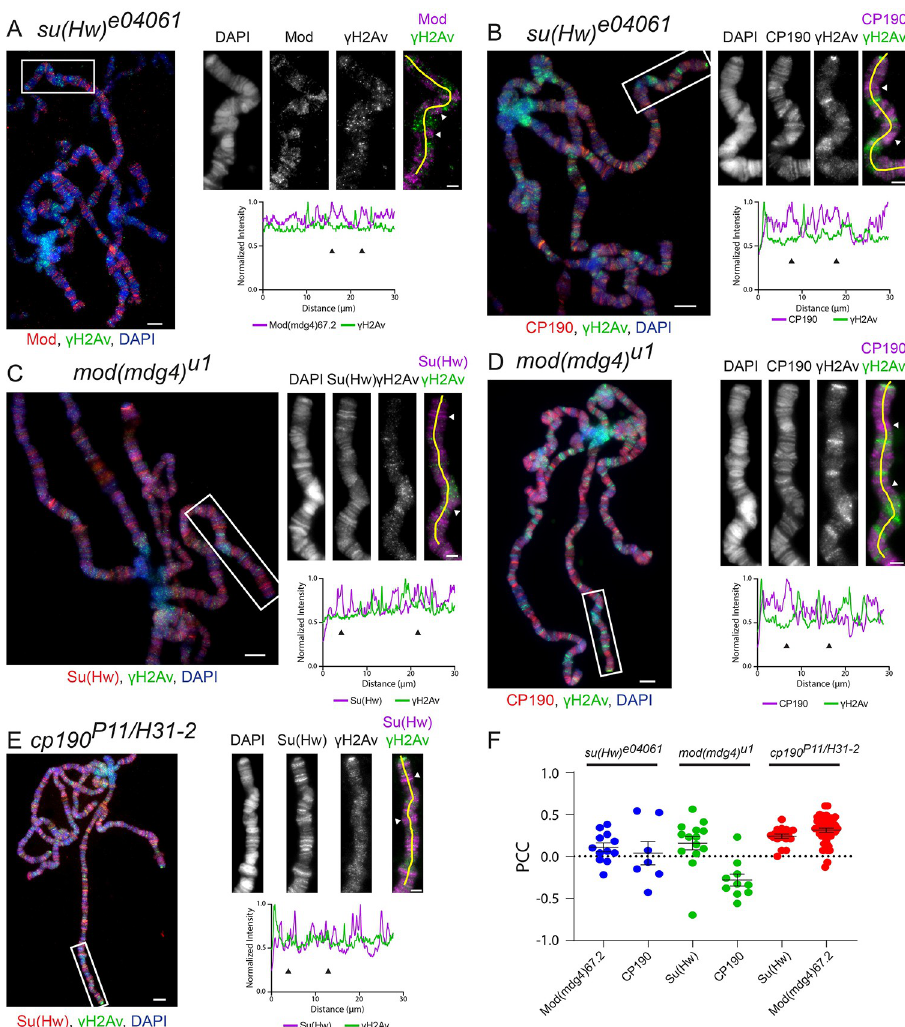
Fig 3. Insulator components are interdependent for their colocalization with γ H2Av in Drosophila polytene chromosomes. A. Colocalization of γ H2Av with Mod(mdg4)67.2 in su(Hw) e04061 . B. Colocalization of γ H2Av with CP190 in su(Hw) e04061 . C. Colocalization of γ H2Av with Su(Hw) in mod(mdg4) u1 . D. Colocalization of γ H2Av with CP190 in mod(mdg4) u1 . E. Colocalization of γ H2Av with Su(Hw) in cp190 P11/H31-2 . F. Pearson’s Correlation Coefficient (PCC) for γ H2Av signal with each insulator signal is plotted, with each point representing the polytene genome of each cell. Error bars represent one standard error of the mean. PCC values are grouped by genotype (red = su(Hw) e04061 , green = mod(mdg4) u1 , blue = cp190 P11/H31-2 ). Immunostains of polytene chromosomes are shown on the left. Magnified insets are shown to the right of each figure, corresponding to the white boxes in the figures on the left. Scale bars are 5 μ m in the figures and 2 μ m in the insets. Beneath the insets are linescans corresponding to the yellow lines in the merged insets. Linescan intensities were normalized by dividing each value by the maximum intensity recorded on each channel. Arrowheads denote regions enriched for insulator proteins but not γ